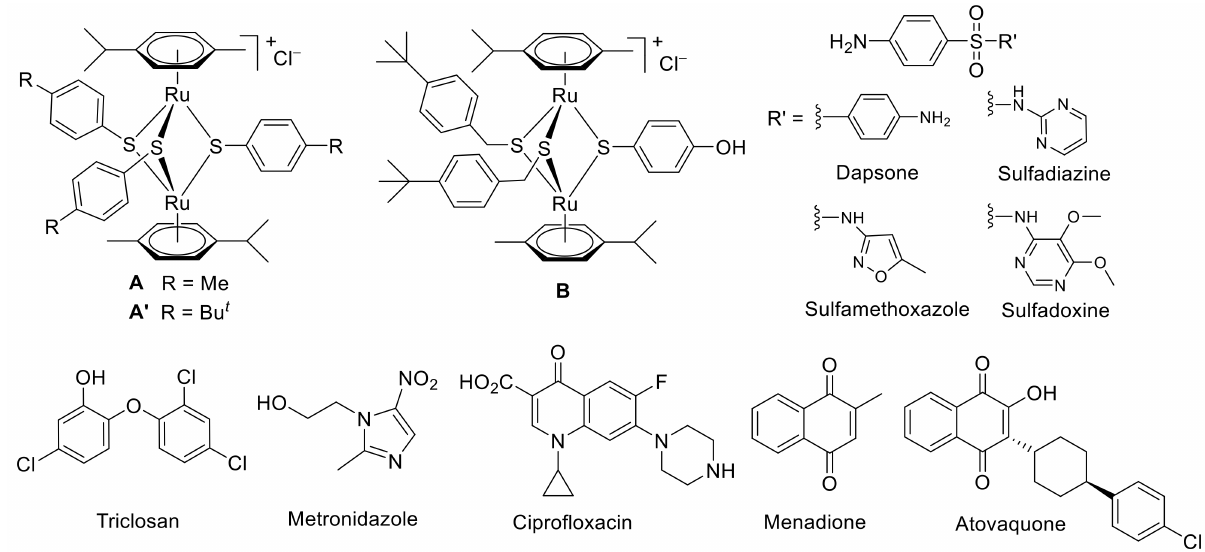
Figure 1. Structure of selected symmetric ( A , A’ ) and mixed ( B ) trithiolato-bridged ruthenium(II)–arene complexes and of the antimicrobial drugs considered for tethering to the diruthenium